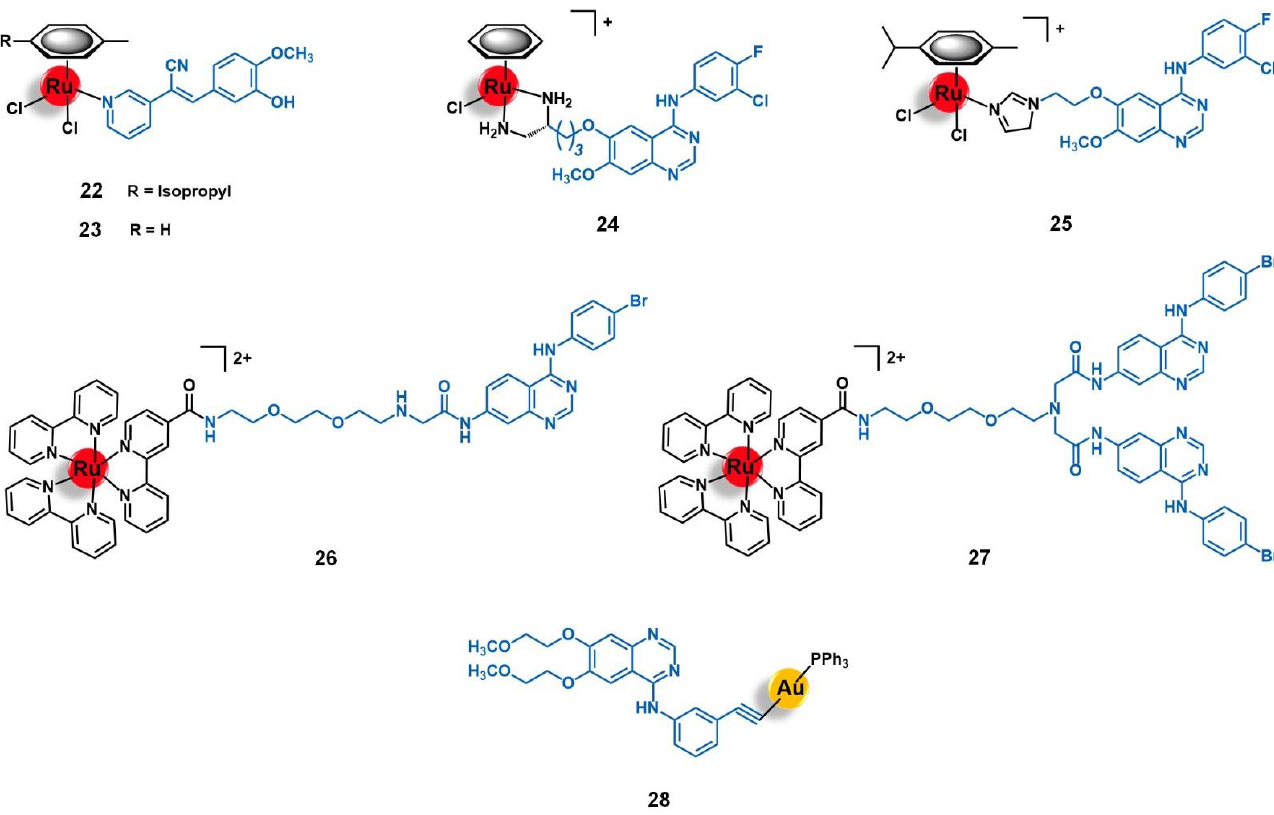
Figure 9. Ru(II) and Au(I) complexes that target the epidermal growth factor receptor (EGFR). The vectorizing agents include tyrphostin-like small molecules ( 22 and 23 ), derivatives of 4-anilinoquinazoline ( 24 to 27 ), and erlotinib ( 28 ).